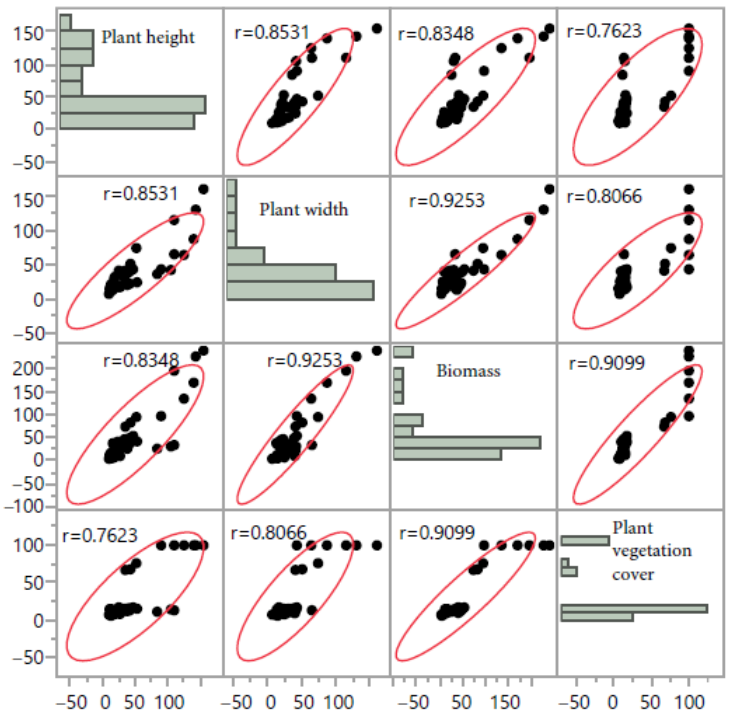
Figure 2. Biomass (g DM plant − 1 ) of twelve native perennial species from arid rangelands of southern Tunisia. Values are the means ± standard error (SE) from 3 replicates (means ± SE). Fodder biomass was correlated with plant height (r = +83, p < 0.0001), plant length (r = +0.93, p < 0.001), and plant vegetation cover (r = +91, p < 0.0001; Figure 3).